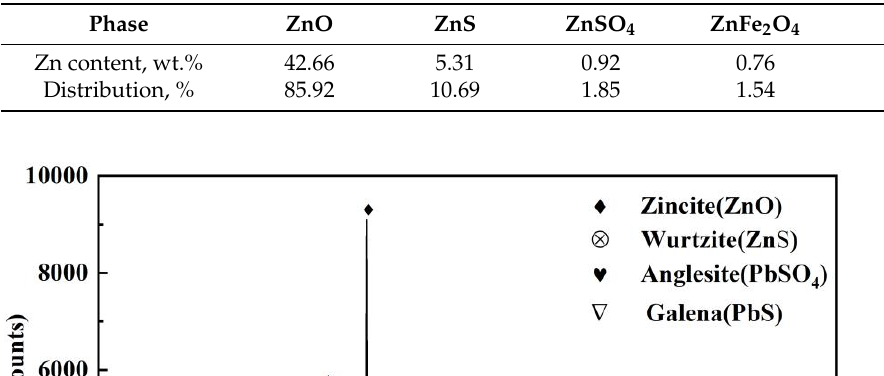
Table 2. Chemical phase analysis results of Zn in GCR.